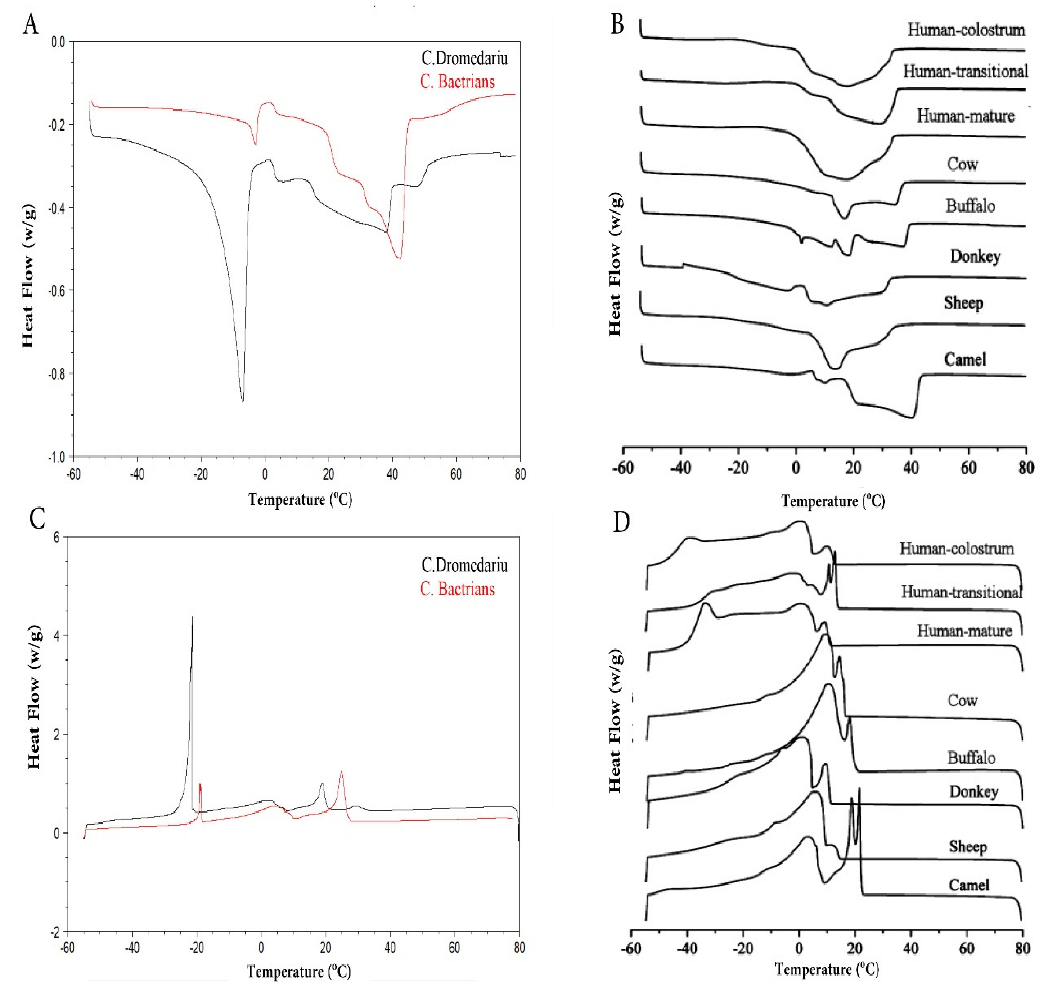
Figure 6. DSC curves of crystallization ( A , B ) and melting ( C , D ) for camel milk and other mammalian milk. Adapted with permission from ref. [12] (Copyright 2020 Elsevier) ( A , C ) and ref. [20] (Copyright 2013 ACS Publications) ( B , D ).